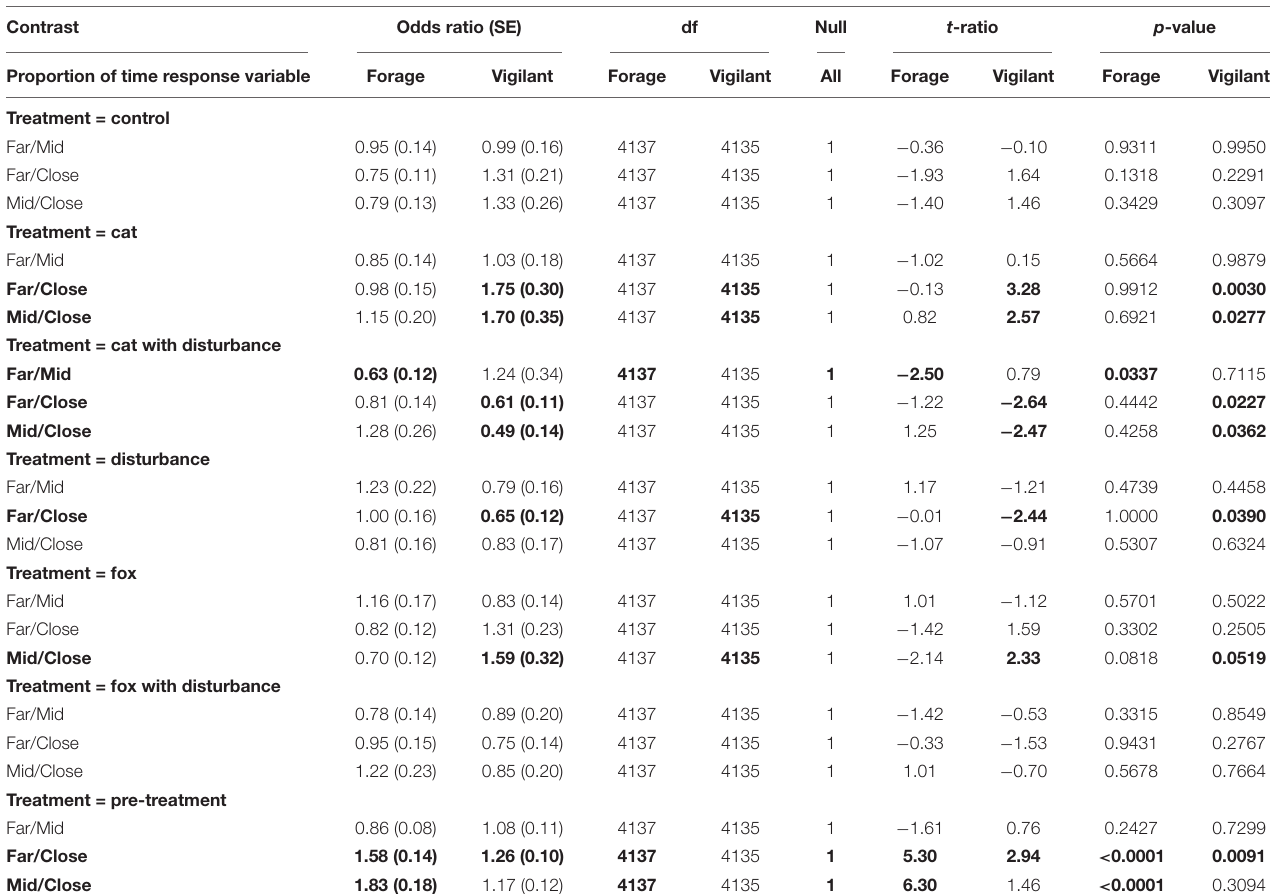
TABLE 7 | Pairwise contrast ratios for estimated marginal means comparing environments (close, mid, and far) along an urban disturbance gradient for animal responses of time spent foraging and time spent vigilant, under the explanatory variables of treatment and environment. Contrast Odds ratio (SE)